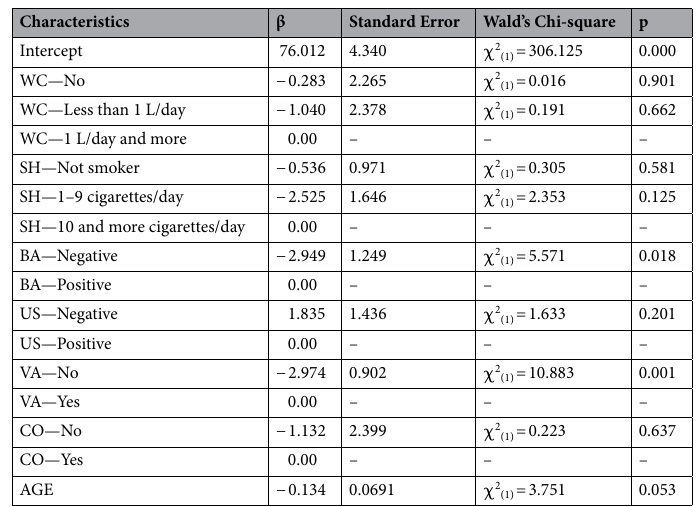
Table 7. Results of the generalized linear model with sperm immaturity (IM) as response variable. WC wine consumption, SH smoking habit, BA semen bacteriological analysis, US urethral swab, VA varicocele, CO consanguinity.